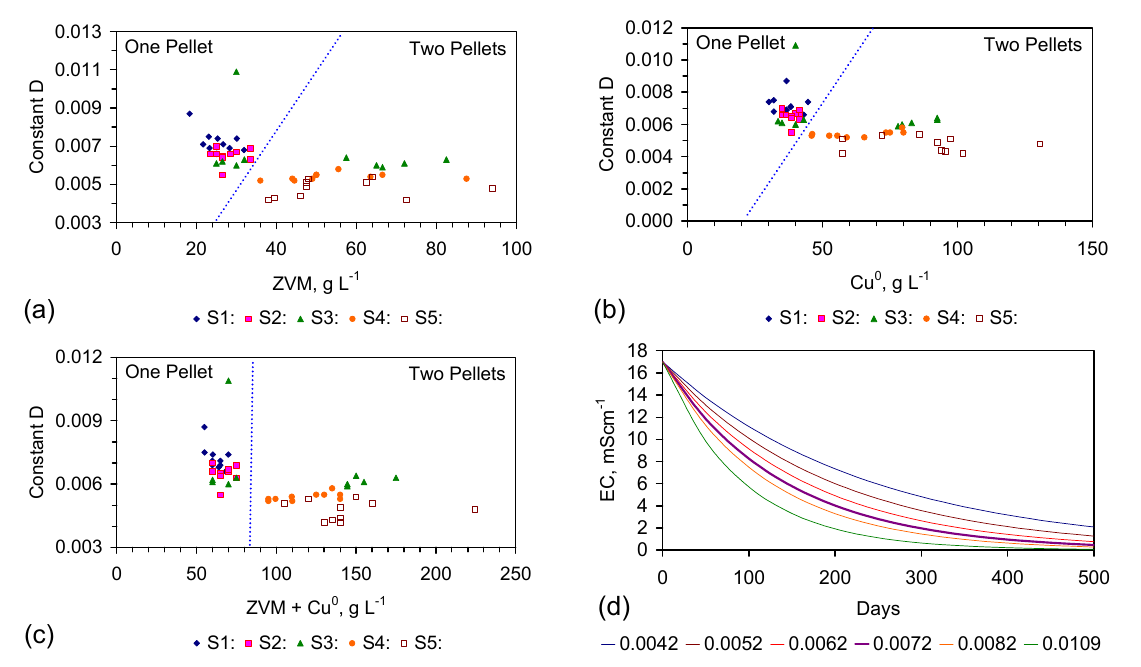
Figure 19. Redox desalination constants (D) associated with an exponential regression correlation. ( a ) Constant D vs. ZVM concentration; ( b ) Constant D vs. weight of Cu 0 pellet sheath; ( c ) Constant D vs. weight of ZVM + Cu 0 pellet sheath; ( d ) EC vs. Length of desalination period (days), for the observed range of values of Constant D, and Constant C (initial salinity) = 17 mS·cm − 1 at t = 0